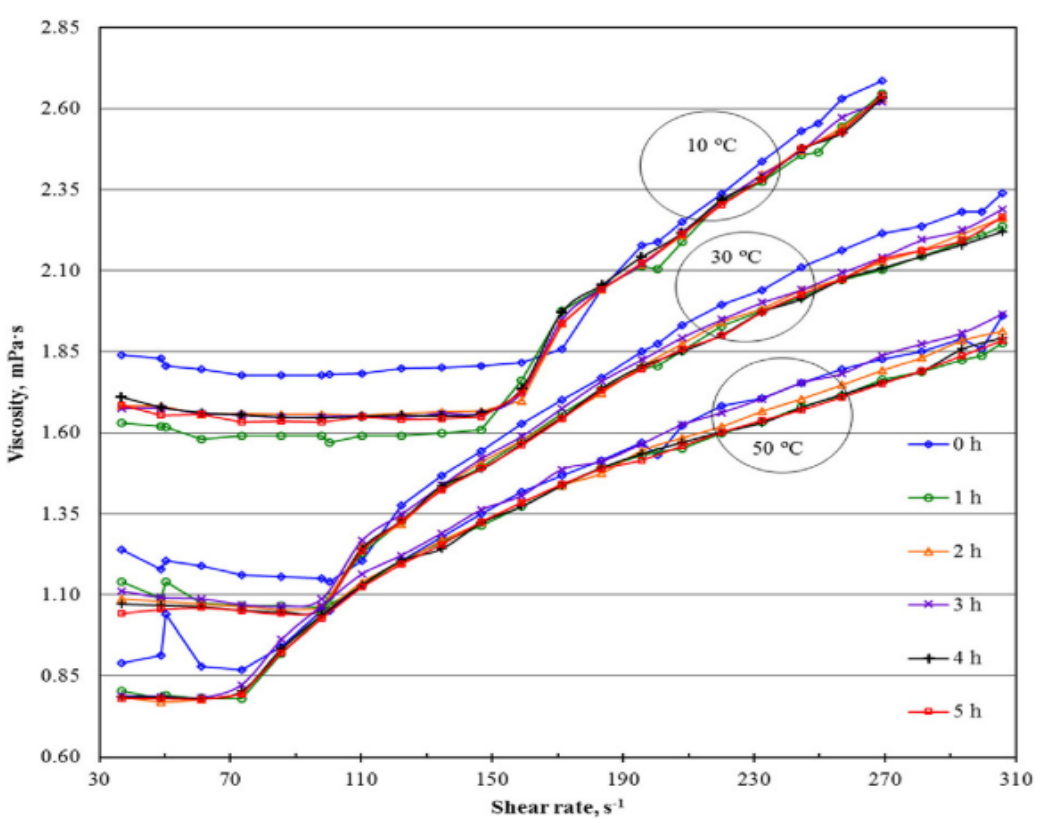
Figure 8. Viscosity against shear rate of Al 2 O 3 NF at different sonication time. Adapted from [165]. The µ behavior of Al 2 O 3 /GL NFs under different volume fractions (1–5%), sonication energy densities (5 × 10 6 –4 × 10 7 kJ/m 3 ), nano-sizes (20–30, 80, and 100 nm), and sonication time (1–8 h) was investigated [74]. The stability is monitored using UV, ZP, and visual